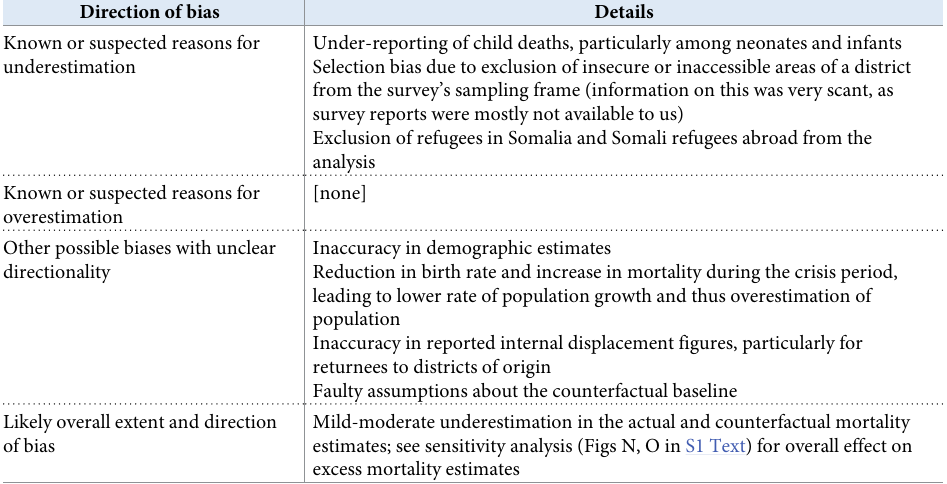
Table 7. Assessment of systematic bias in the